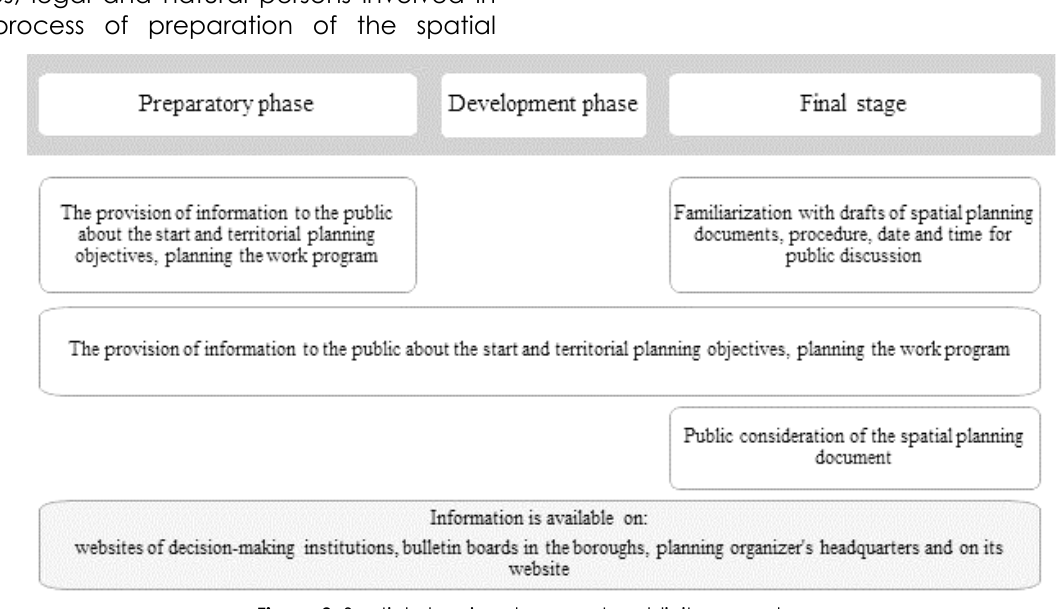
Figure 3. Spatial planning documents publicity